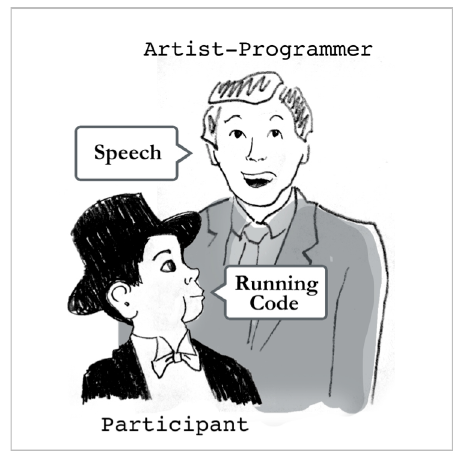
Figure 3 | Initial ventriloquism diagram for code-based participatory